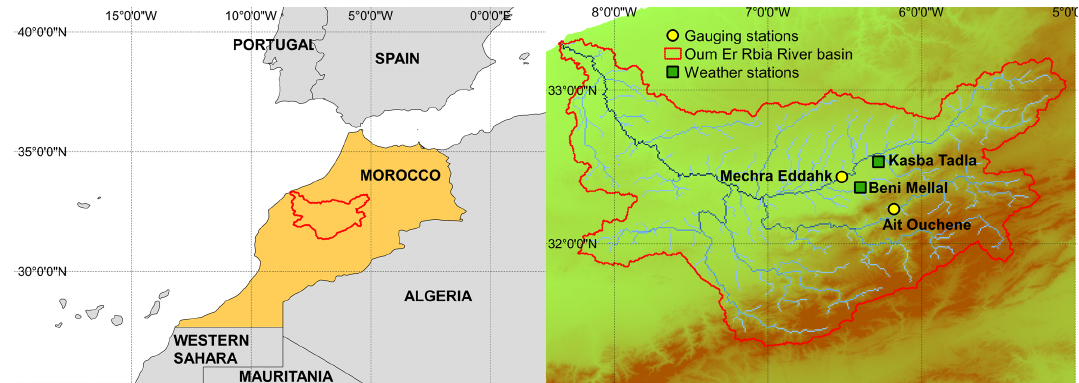
Figure 1. Oum er Rbia River basin and its location in Morocco (the delineation of the catchment is physically based). Yellow points represent the gauging stations and green squares represent the weather